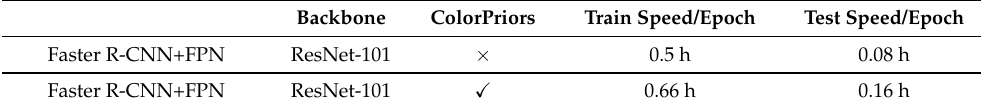
Table 2. Speed comparison of whether to use the color prior model (datasets:VOC2007).